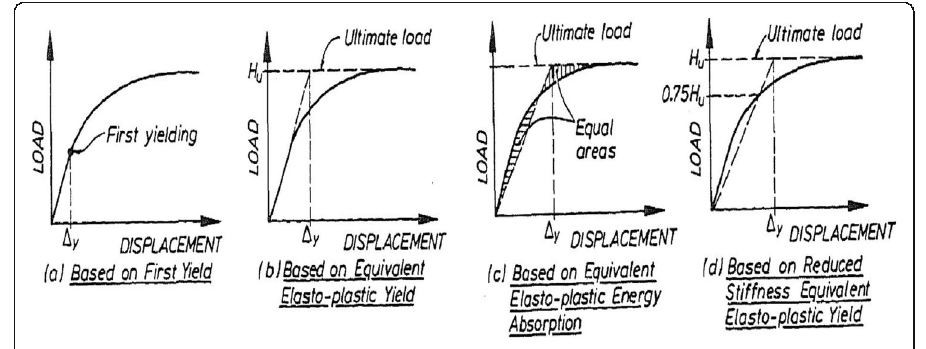
Fig. 17 Alternative definition for yield displacement [30]